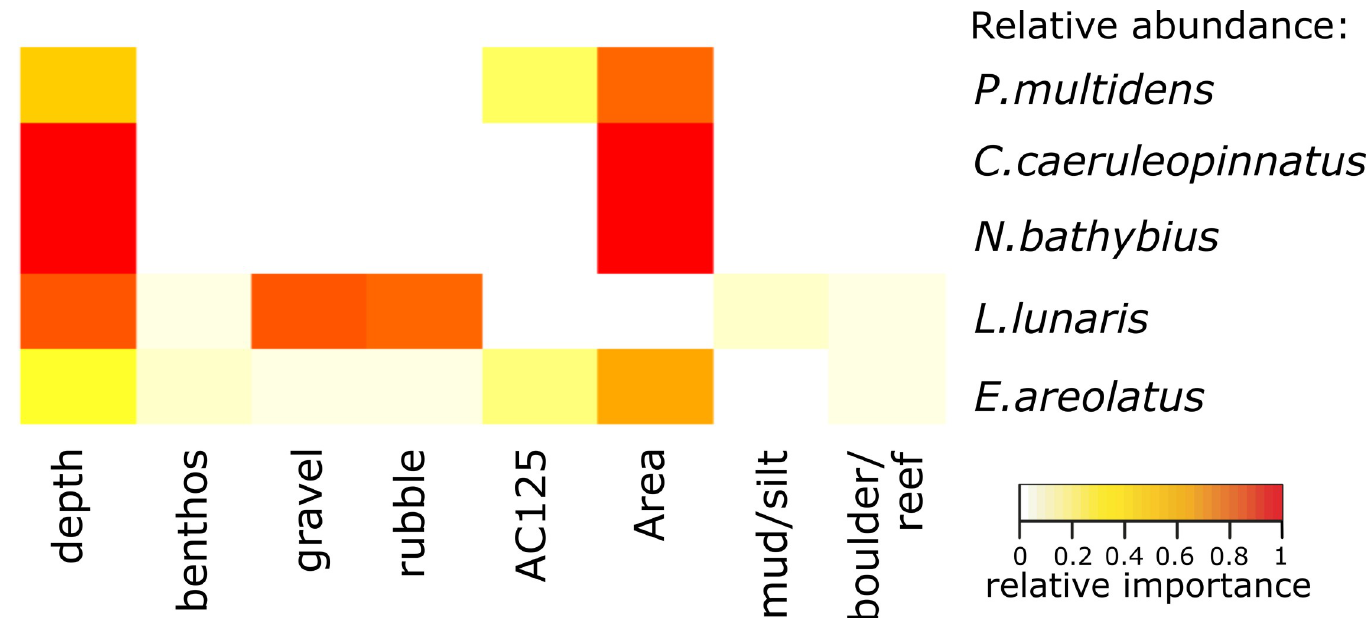
Fig 5. Heatmap indicating the key predictors from the GAMM models of most common species relative abundance. Colours indicate relative importance.